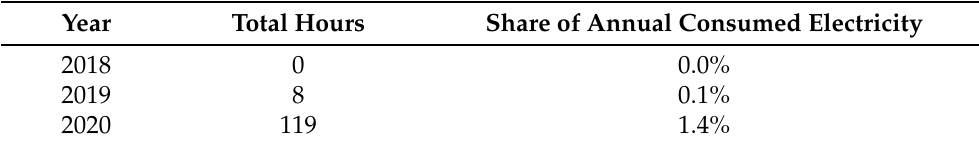
Table 6. Hours and annual share of the whole consumed electricity when wind and solar generated more than 50% of consumed electricity in Belgium